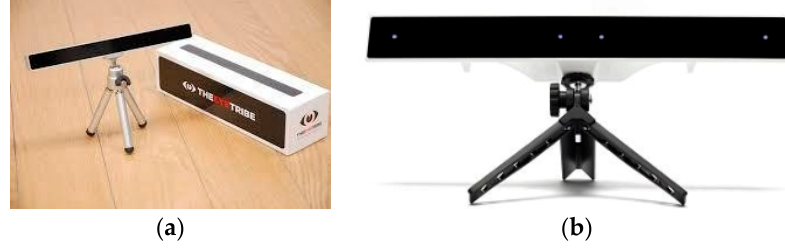
Figure 6. The Eye Tribe tracker [15] ( a ), the Gazepoint GP3 Eye tracker [14] ( b ).